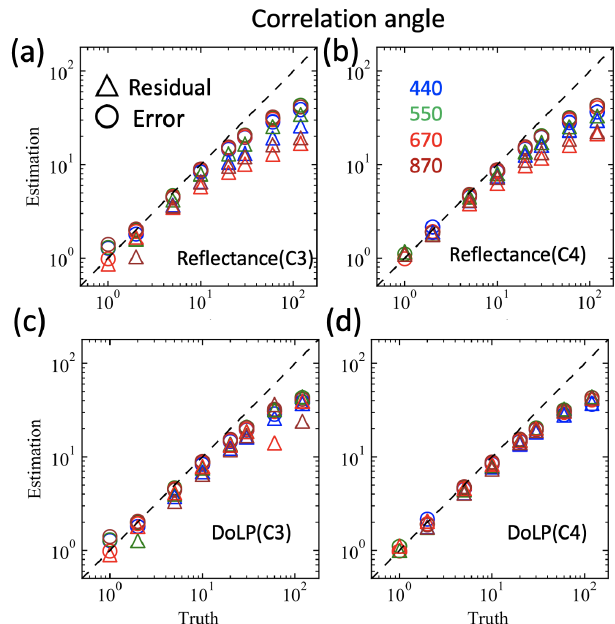
Figure 12. The estimated correlation angle θ c for scenarios C3 and C4 from the simulated measurement errors and fitting residu- als for reflectance and DoLP are compared with the truth values. The dashed line indicates the one-to-one line. Results of scenarios C1 and C2 for reflectance are similar, but with the estimated corre- lation angle close to zero since no correlation is considered in DoLP (not